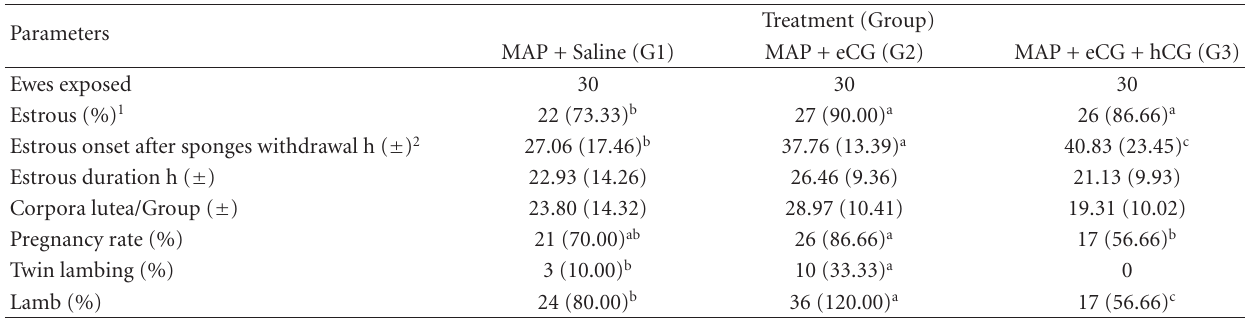
Table 1: Performance of the Texel ewes fertility in out-of-season (means ± standard deviation and